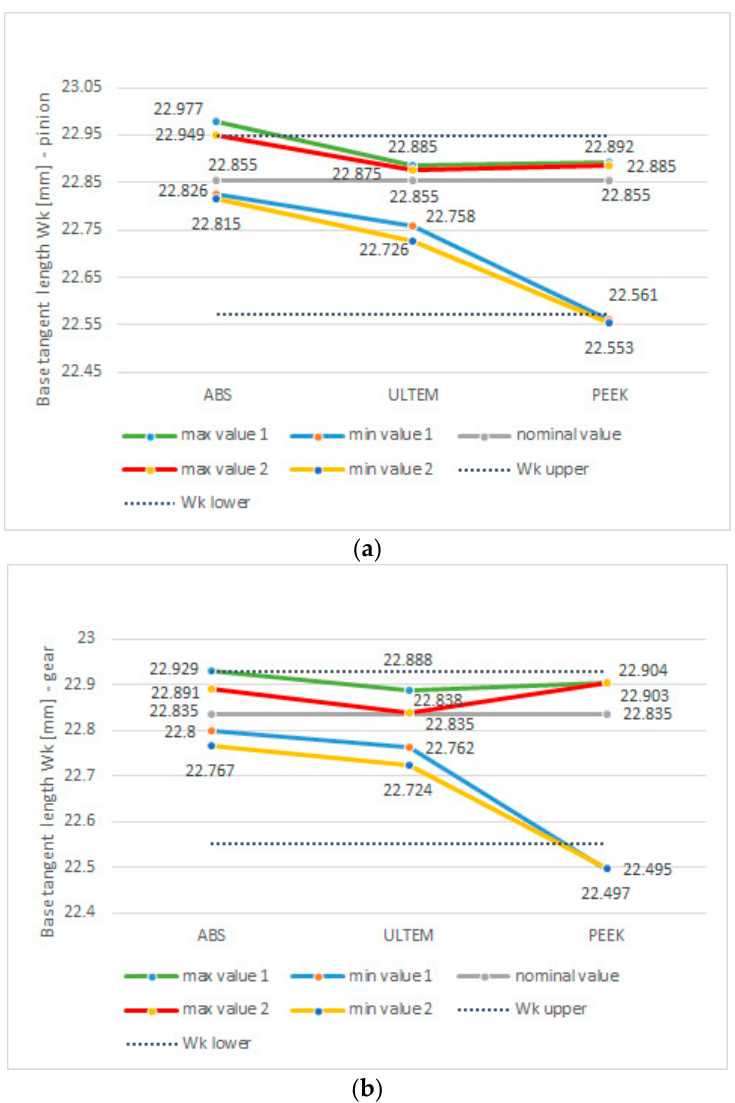
Figure 9. Base tangent length over k teeth for: ( a ) pinion; ( b ) gear wheel, 1—after printing, 2—after test rig.